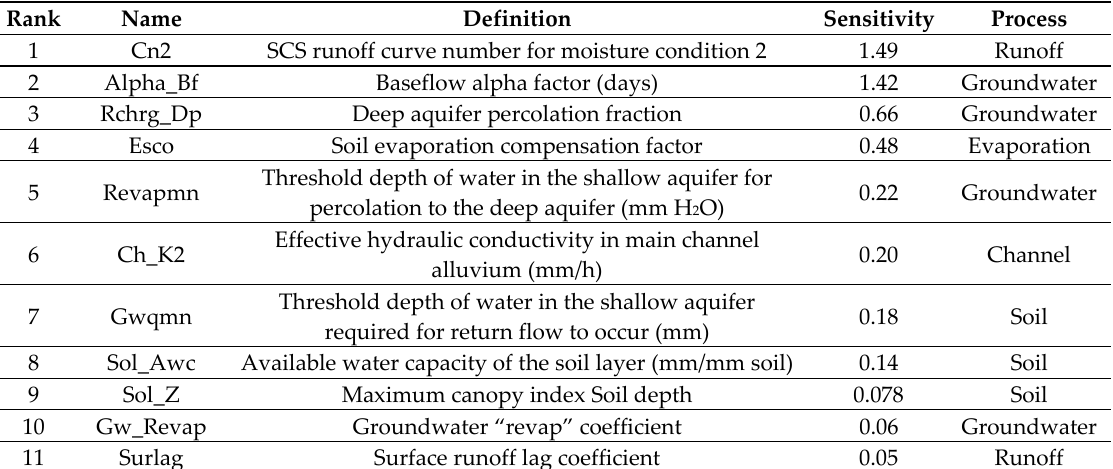
Table 5. Top 11 parameters yielded by the sensitivity analysis.